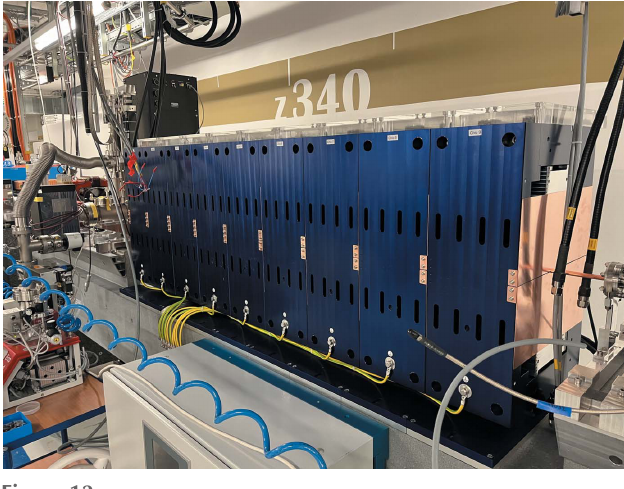
Figure 12 The second modulator downstream in the SwissFEL tunnel. This unit was already tested with an electron beam of about 3